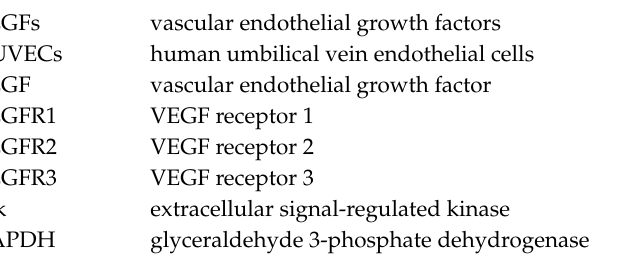
Figure S1: VEGF promotes endothelial cell proliferation in a dose dependent manner, Figure S2: Piceatannol exerts inhibitory e ff ects in VEGF triggered cell proliferation and piceatannol alone does not a ff ect endothelial cell morphology, Figure S3: Piceatannol analogues bind with VEGF, Figure S4: Piceatannol suppresses VEGF induced cancer cell proliferation, Figure S5: E ff ects on expressions of P-VEGFR2 and VEGFR2, Figure S6: E ff ects on expressions of P-VEGFR1 and VEGFR1, Figure S7: E ff ects on expressions of P-Akt and Akt, P-Erk and Erk, Figure S8: E ff ects on expressions of specific